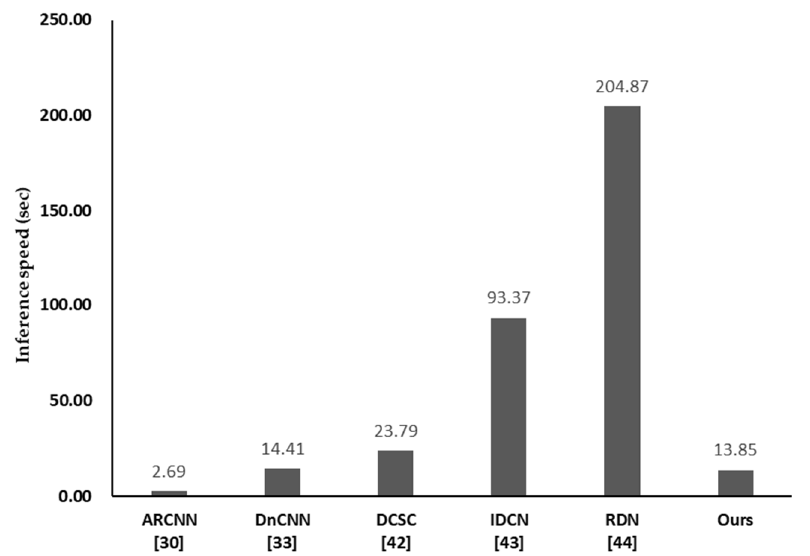
Figure 9. Inference speed on Classic5.